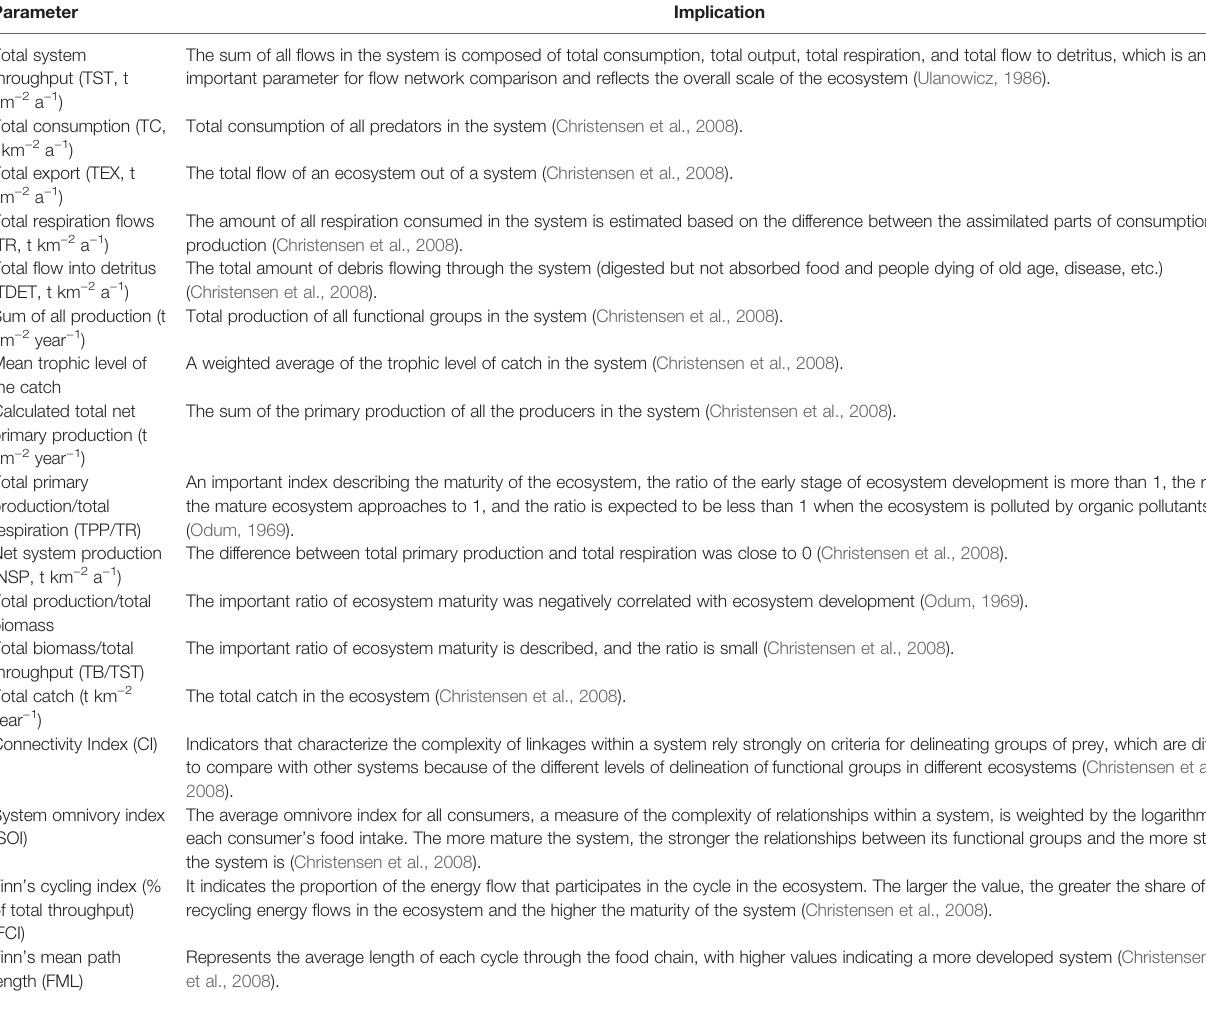
TABLE 1 | Ecopath model parameters and their